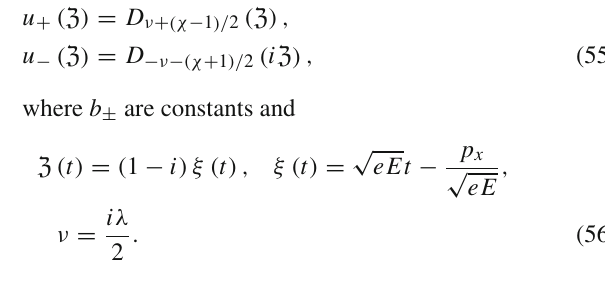
Fig. 5 Differential mean number N cr n of Fermions (left panel) and Bosons (right panel) created from the vacuum by an inverse square decreasing electric field (41). The exact differential mean N cr n given by the absolute squared value of Eq. (44) are represented by solid lines